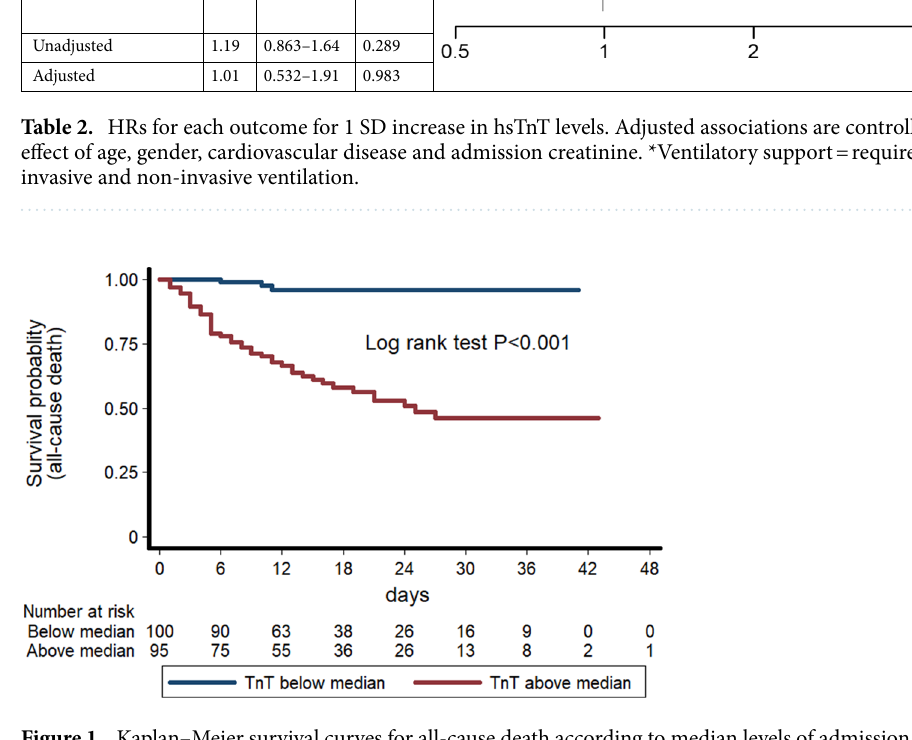
Figure 1. Kaplan–Meier survival curves for all-cause death according to median levels of admission hsTnT levels (blue line = below median; red line = above